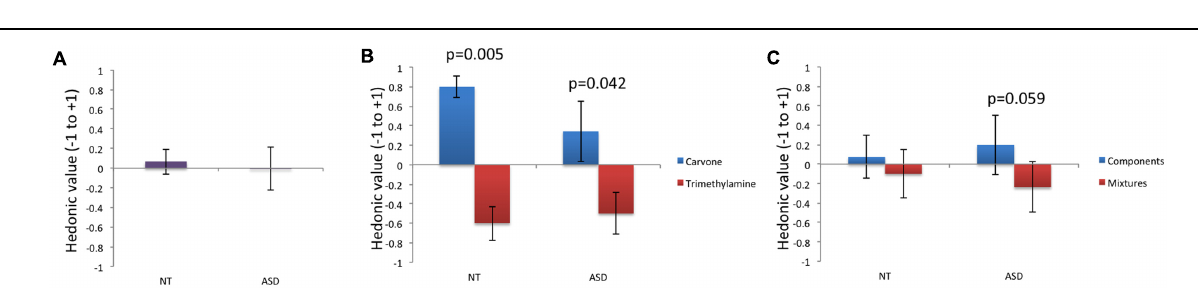
FIGURE 1 | Odor identification and odor familiarity. (A–C) Odor identification performance did not differ between groups or between odor conditions within groups. A trend ( p < 0.10) toward better identification of the pleasant odor (Carvone) than the unpleasant odor (Trimethylamine) was observed in the NT group. (D–F) For familiarity ratings, no significant effect of group or odor condition (within group) was observed.